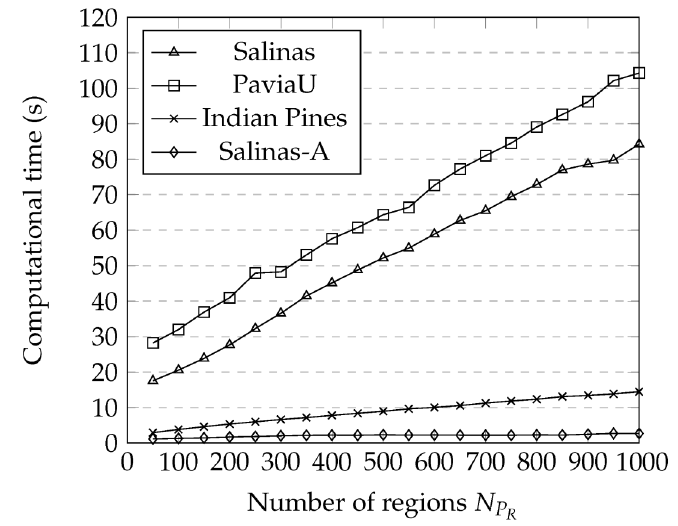
for the proposed method. R